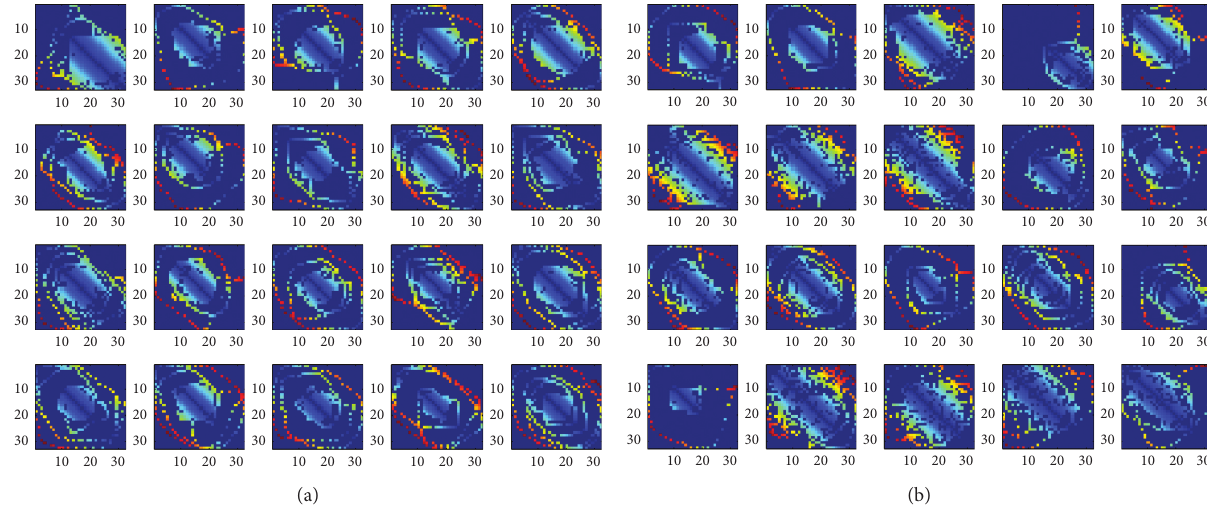
Figure 8: The mesh phase portraits. (a) Fault response fragments of the outer ring. (b) Fault response fragments of the inner ring.